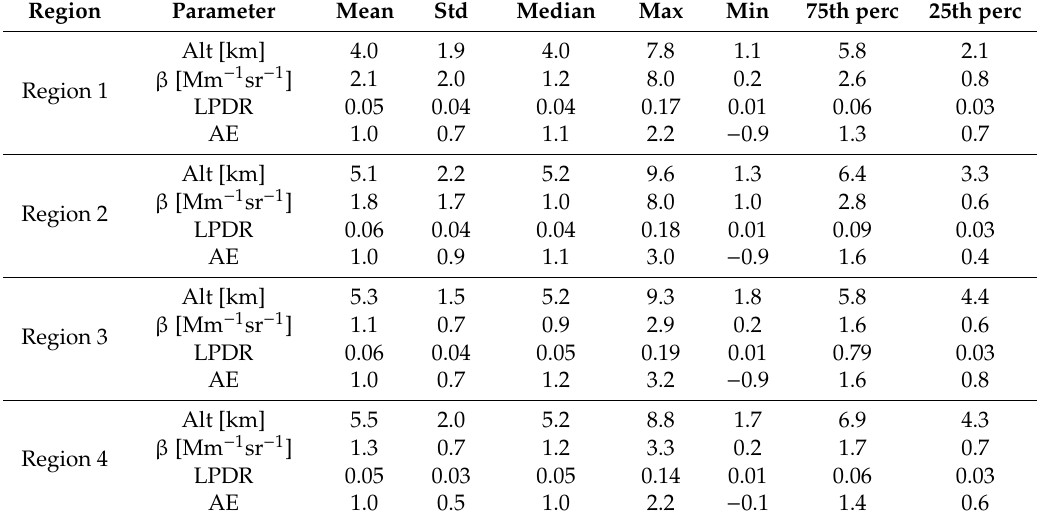
Table A5. Descriptive Statistics: mean, standard deviation (std), median, maximum value (max), minimum value (min), 75th and 25th percentile for all variables regarding the pure smoke